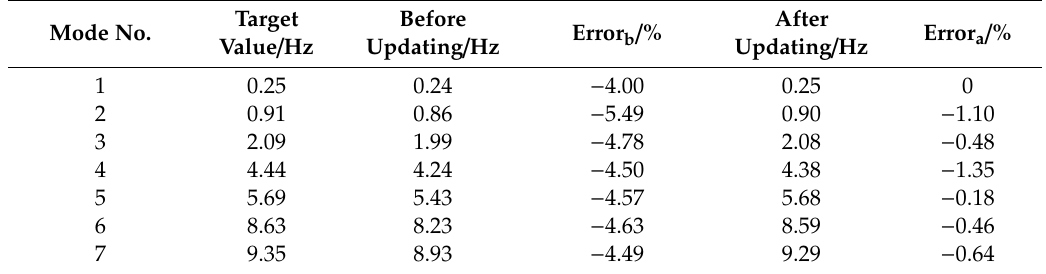
Table 5. Comparison of Frequency Values between FE Model and Target model Under 5% White